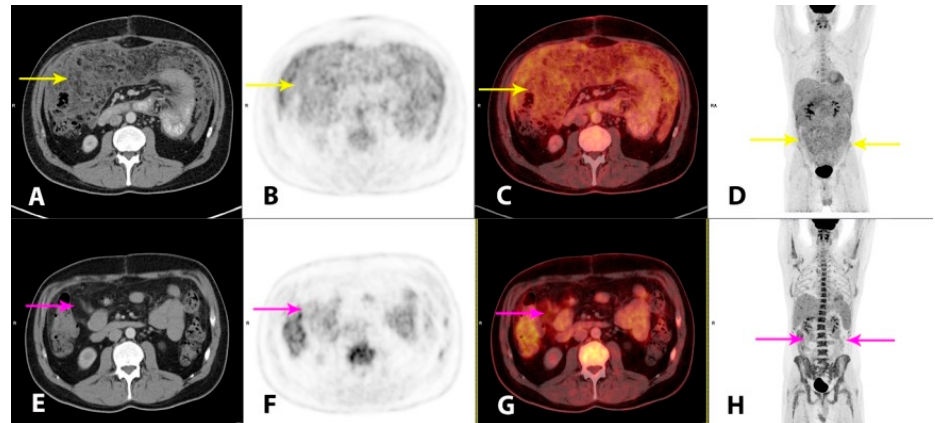
Figure 3. Hybrid imaging with 2-deoxy-2-[ 18 F]fluoro-D-glucose positron emission tomography/CT (2-[ 18 F]FDG PET/CT) was performed for the staging of the disease and as baseline for